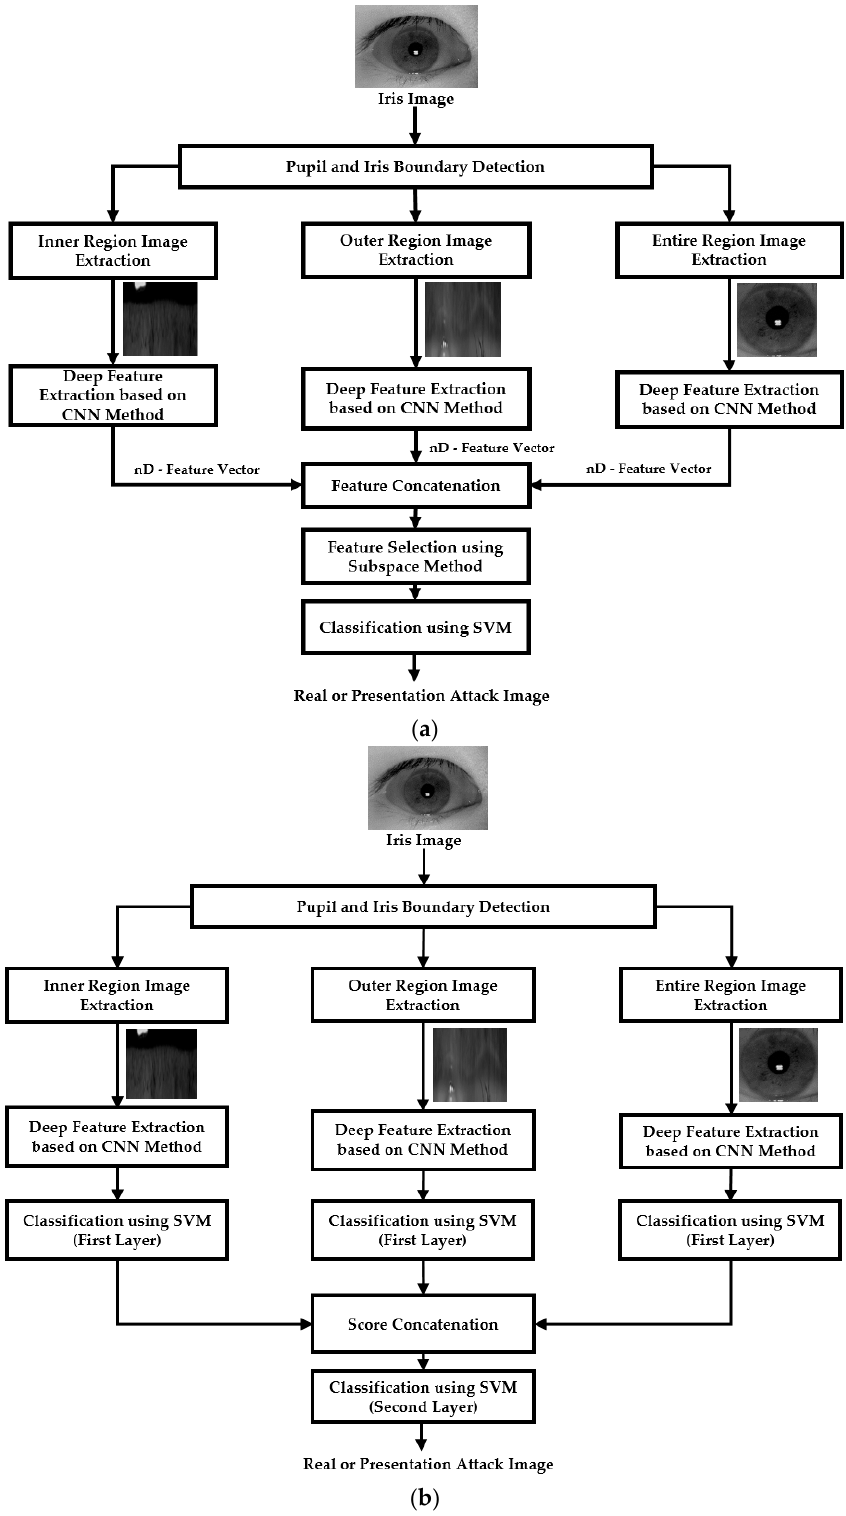
Figure 1. Overview flowchart of our proposed method for iPAD: ( a ) feature level fusion (“nD ‐ Feature Vector” denotes n ‐ dimensional feature vector), and ( b ) score level fusion.